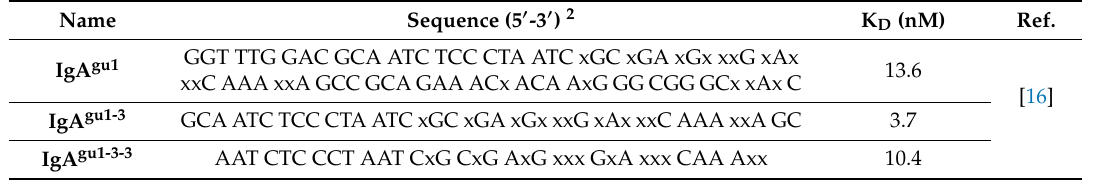
Table 2. Selected aptamers against SIgA and their equilibrium dissociation